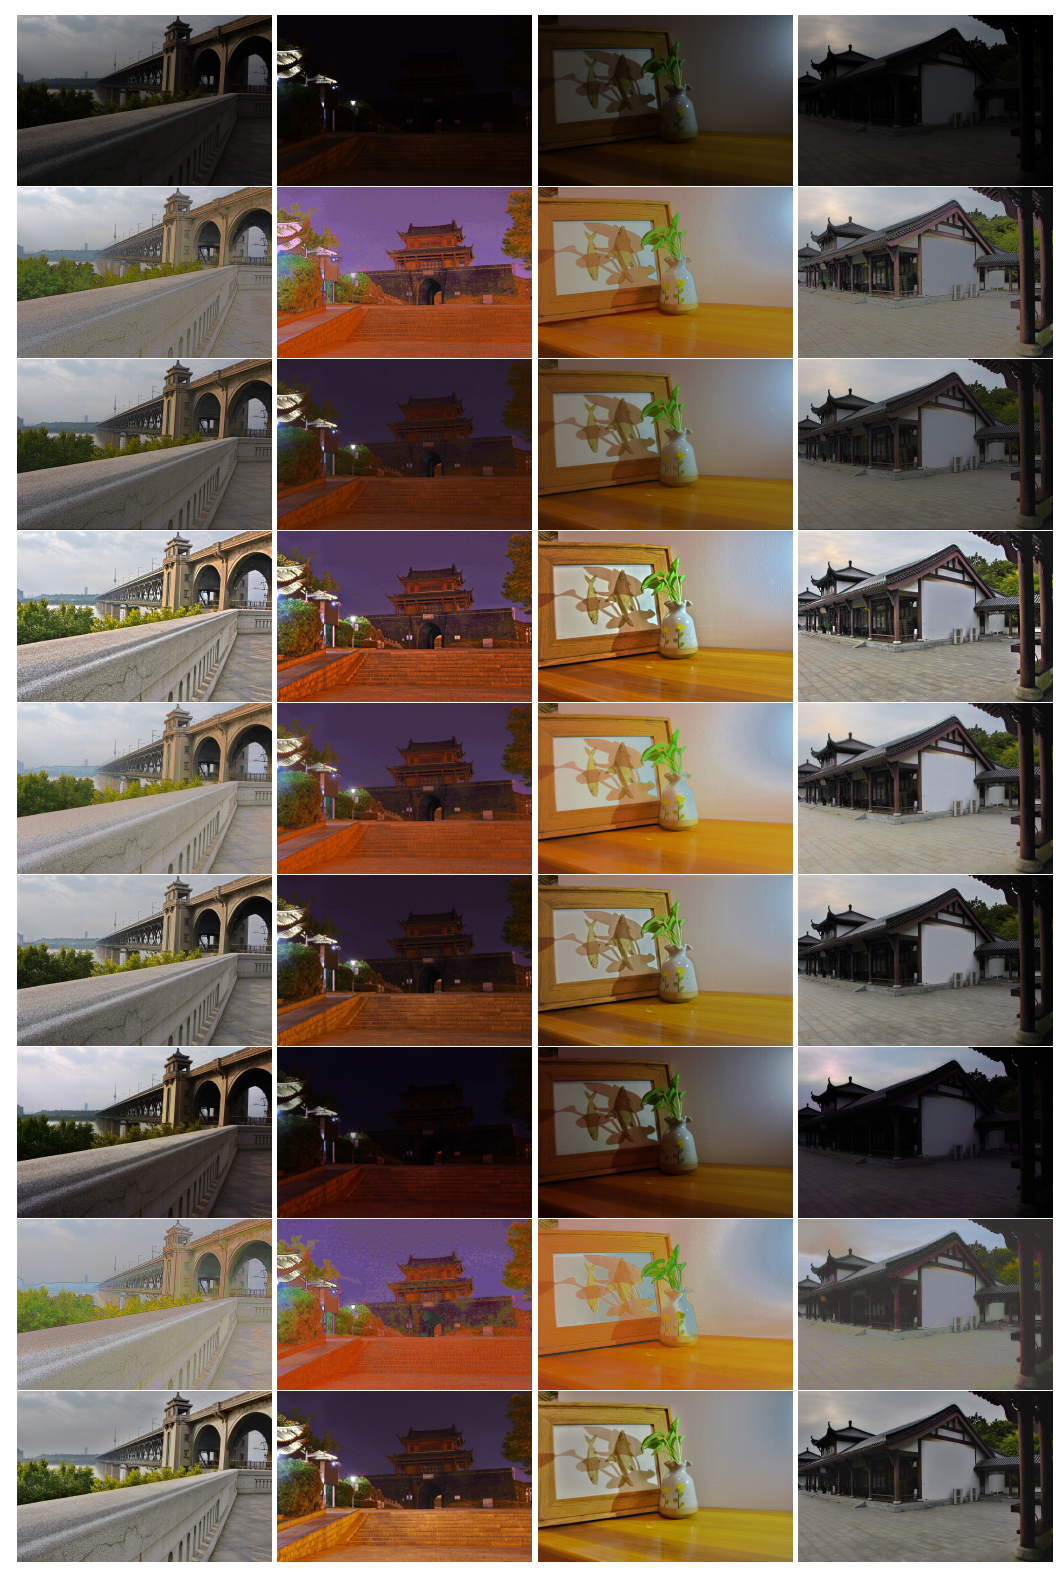
Figure 8. The brightened night images of eight algorithms. The first row shows the input images, the second row is performed using NPE [7], the third row using SNIE [13], the fourth row using LIME [10], the fifth row using Dong [8], the sixth row using LECARM [15], the seventh row using [18], the eighth row using [19], and the last row is by our